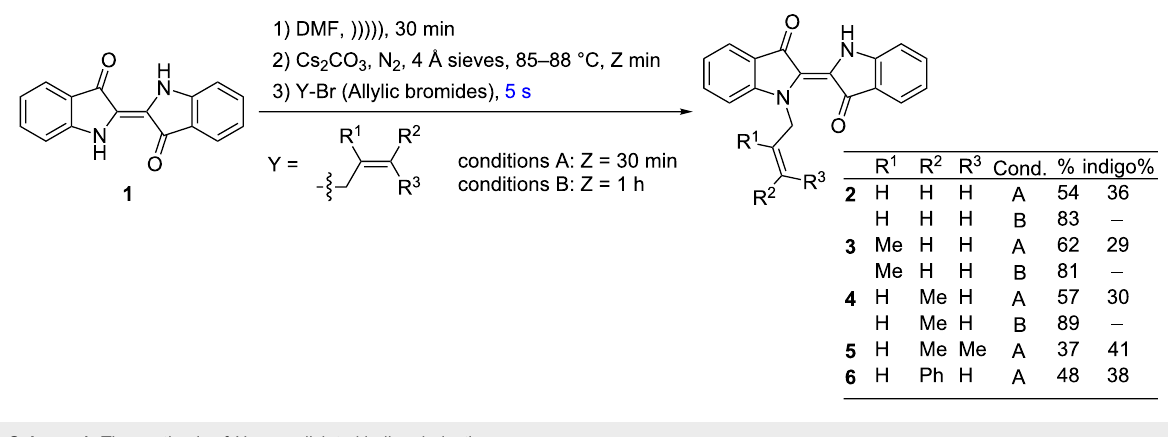
Scheme 1: The synthesis of N -monoallylated indigo